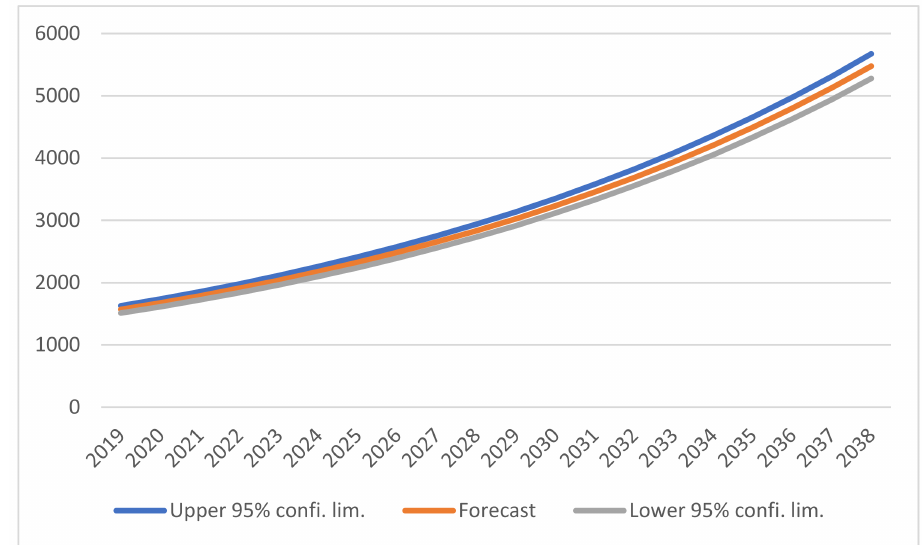
Figure A1. Forecast total energy demand for model 1 and upper and lower confidence limit at 95% (model